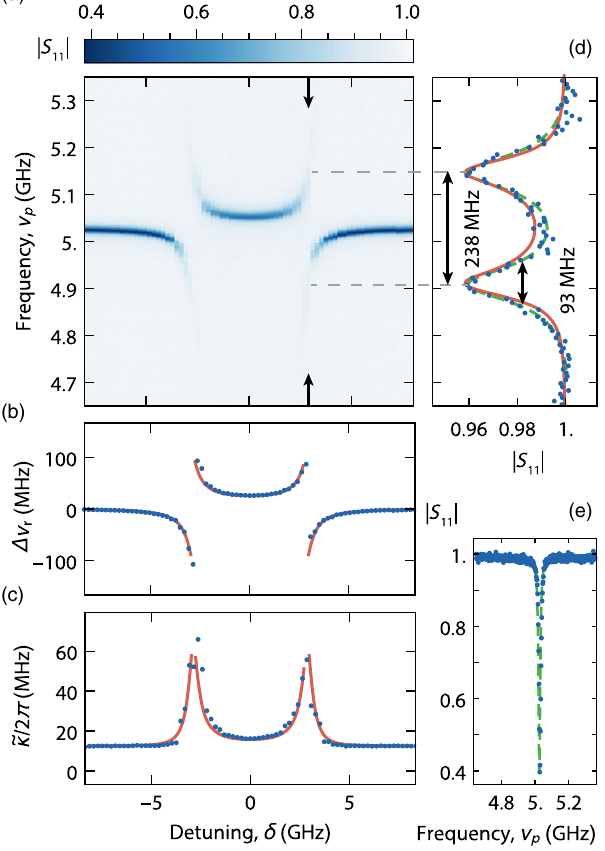
FIG. 3. Dispersive and strong resonant interactions. (a) Reso- nator reflectance j S 11 j as a function of probe frequency ν and p ν DQD detuning δ . The resonance ( ν ) occurring at δ is q ¼ r (cid:2) indicated by arrows. (b) Extracted resonator frequency shift Δ ν r (dots) and (c) linewidth ~ κ (dots) vs DQD detuning δ in comparison to results of a master equation simulation (line) for ð g 0 ; γ b 1 ; γ b φ Þ = ð 2 π Þ ¼ ð 155 ; 35 ; 63 Þ MHz. (d) Measured reso- nator reflectance j S 11 j (dots) vs probe frequency ν at resonance p ν ( ν ), displaying a strong-coupling vacuum Rabi mode q ¼ r splitting. The solid line is the result of the master equation simulation; the dashed line is a fit to a superposition of two Lorentzian lines. (e) Resonator reflectance spectrum j S 11 j with a Lorentzian fit (dashed line) in the dispersive regime vs probe frequency ν . p